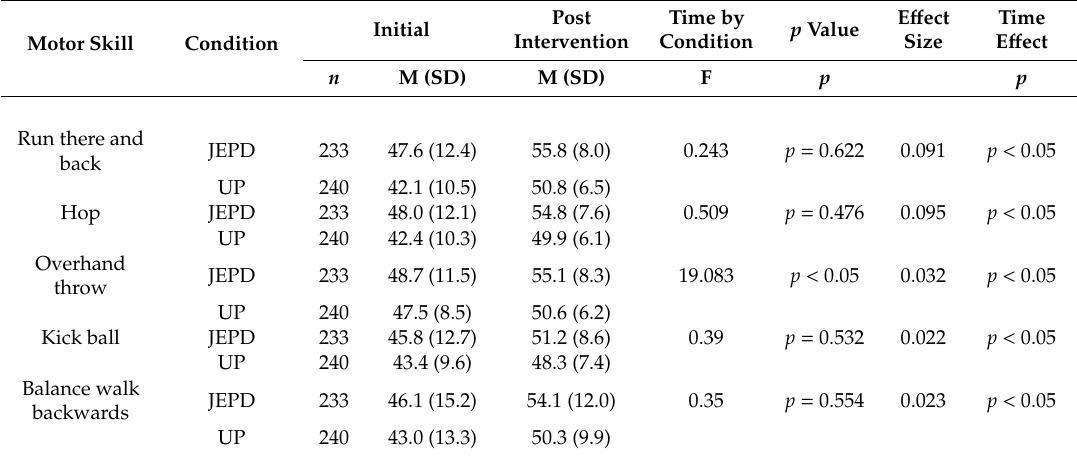
Table 8. Results of the repeated measures ANOVA examining changes in motor skills among children involved in the Fall JEPD compared to those in the Usual Practice wait-list condition.